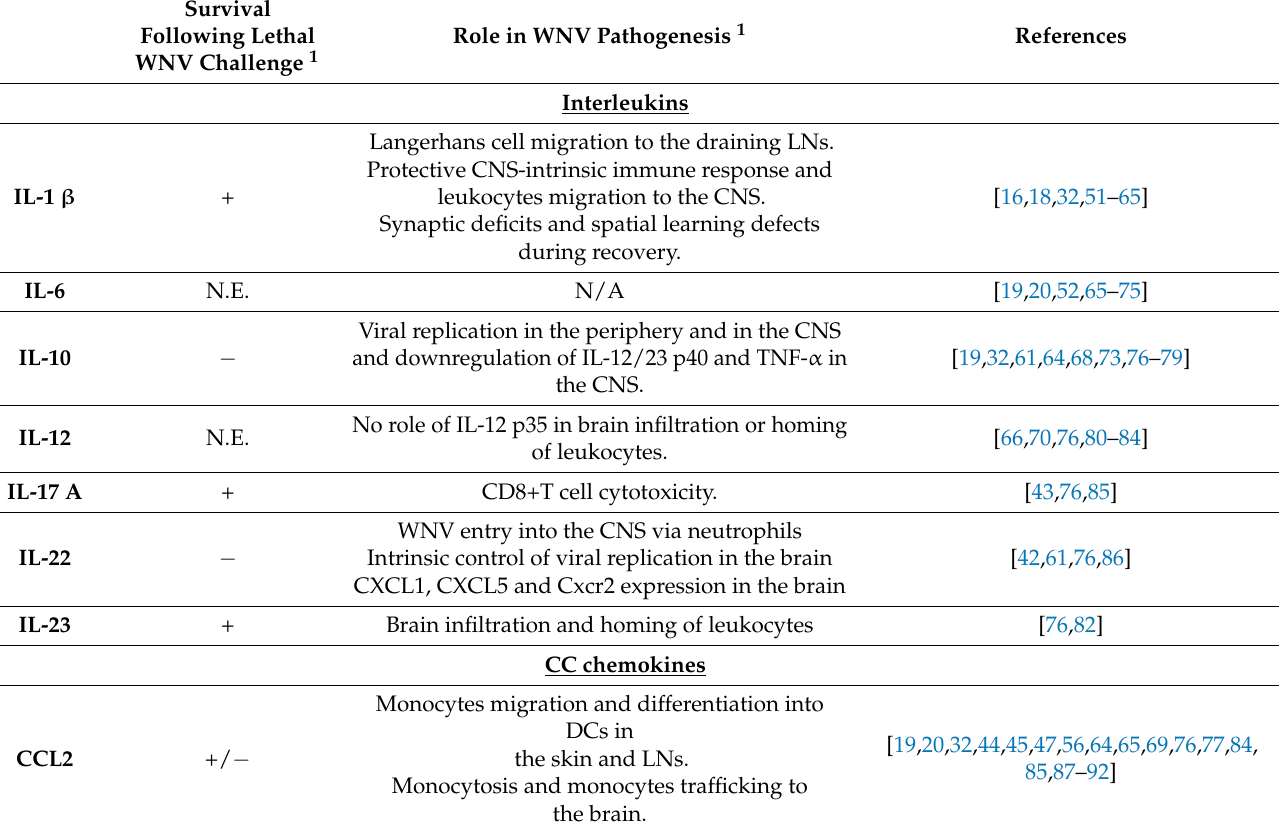
Table 1. Summary of interleukins, chemokines, chemokine receptors and tumor necrosis factor ligands triggered following West Nile virus (WNV) infection, whose pathogenesis has been studied in mice models in